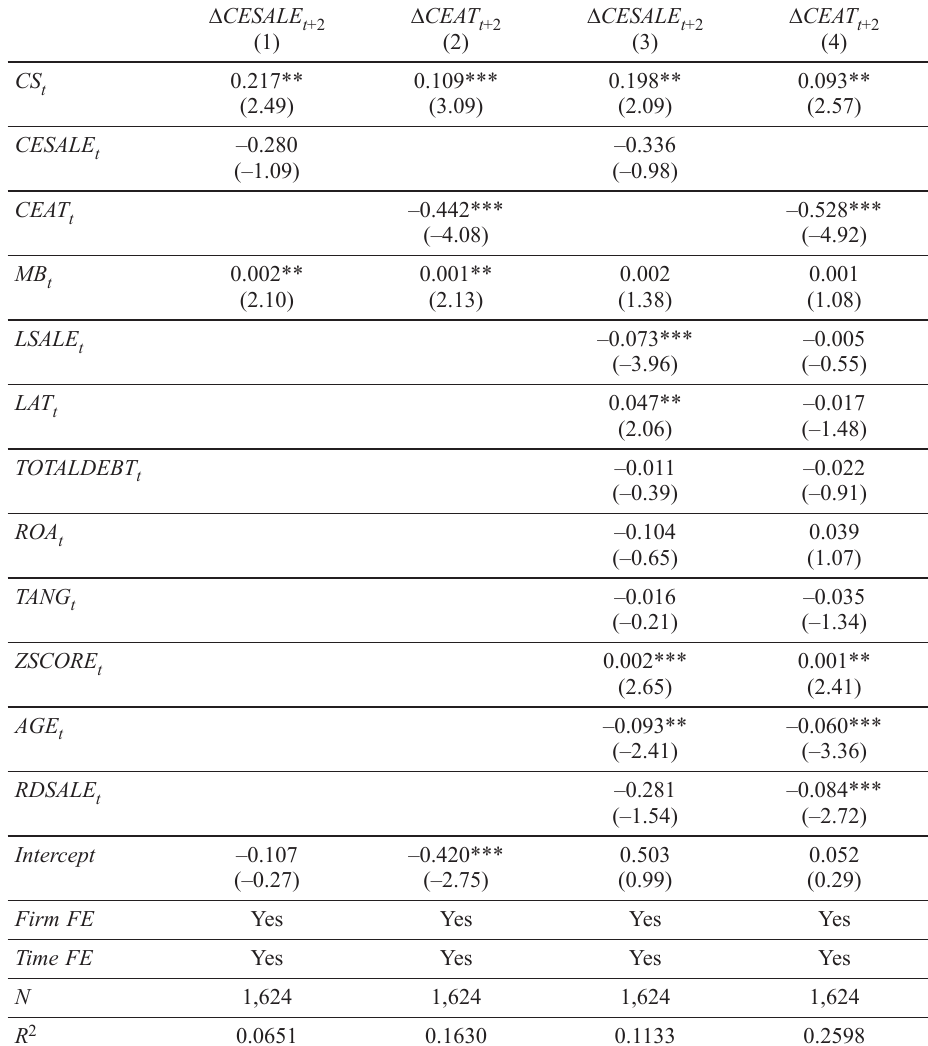
Table 2b. Two-year period, customer satisfaction and capital